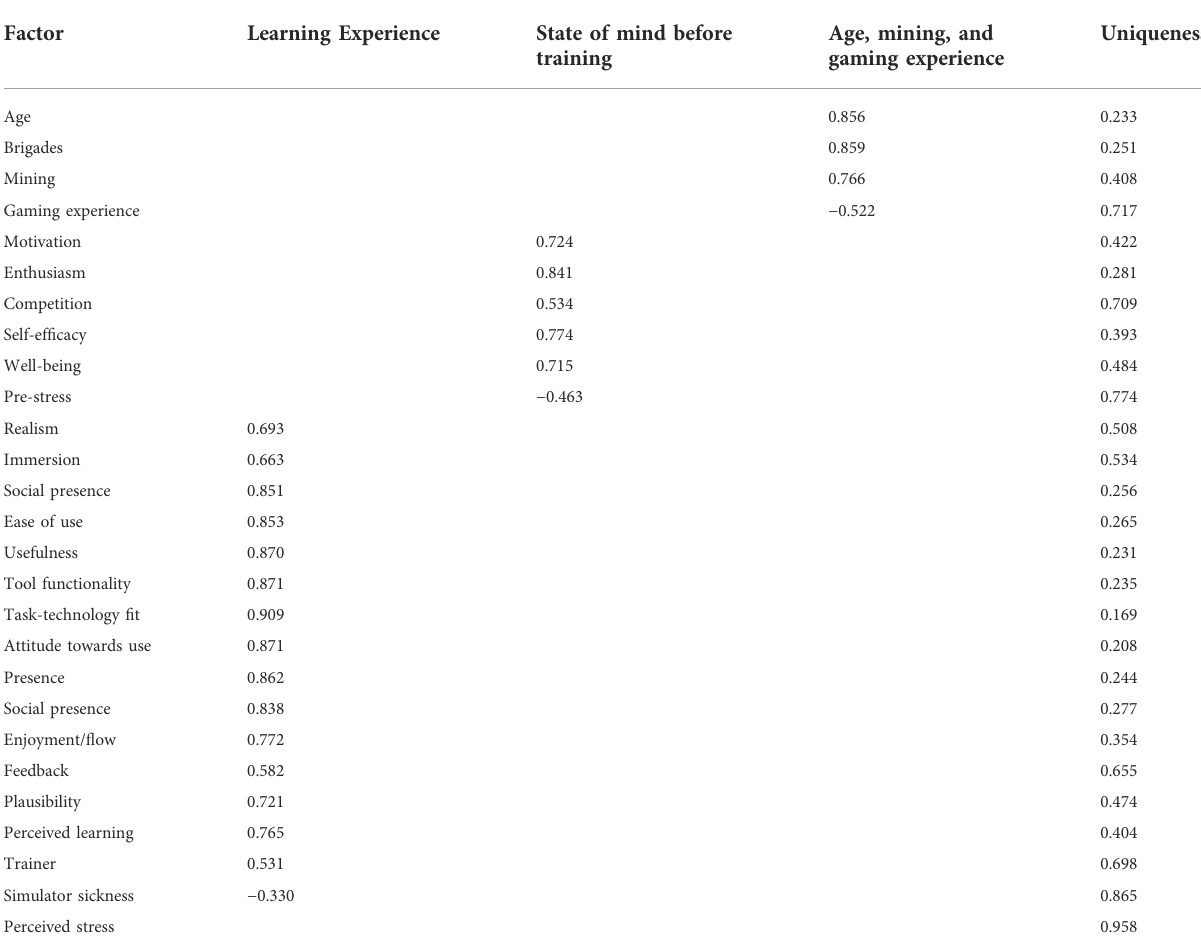
TABLE 4 Component loadings for the PCA.